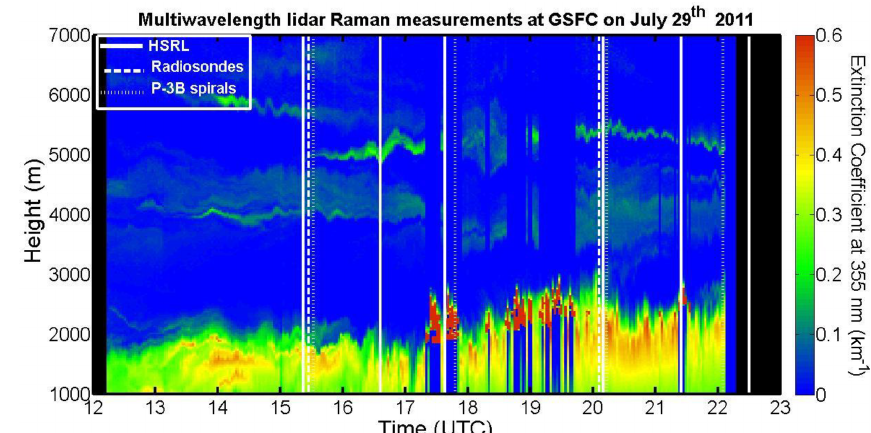
Figure 4. Time evolution of aerosol extinction coefficient at 355nm from GSFC Raman lidar measurements on 29 July 2011. Extinction data are computed using the Klett method with a lidar ratio of 85sr. Vertical resolution is 7.5m. Also noted in the plot are overpasses by the HSRL-1 system and correlative spirals by the P-3B airplane with in situ instrumentation close to GSFC-HUBC region. Times when radiosondes were launched are also illustrated.